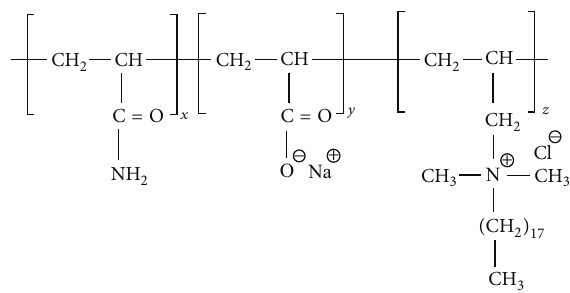
Figure 2: Molecular structure of hydrophobically associating poly- acrylamide (HAPAM) (theoretical mole percents of 𝑥 , 𝑦 , and 𝑧 were about 79.7%, 20.2%, and 0.1%,